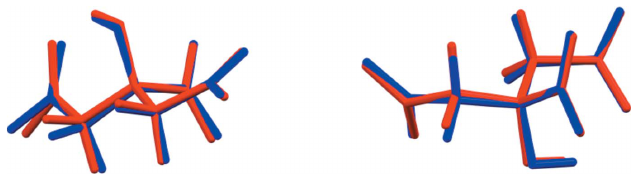
Figure 2 Comparison of the refined and optimized structures of the citrate anions in (I). The refined structure is in red, and the DFT-optimized structure is in blue. Citrate ion 1 (C1–H18) is on the left, and citrate ion 2 (C21–H38) is on the right.